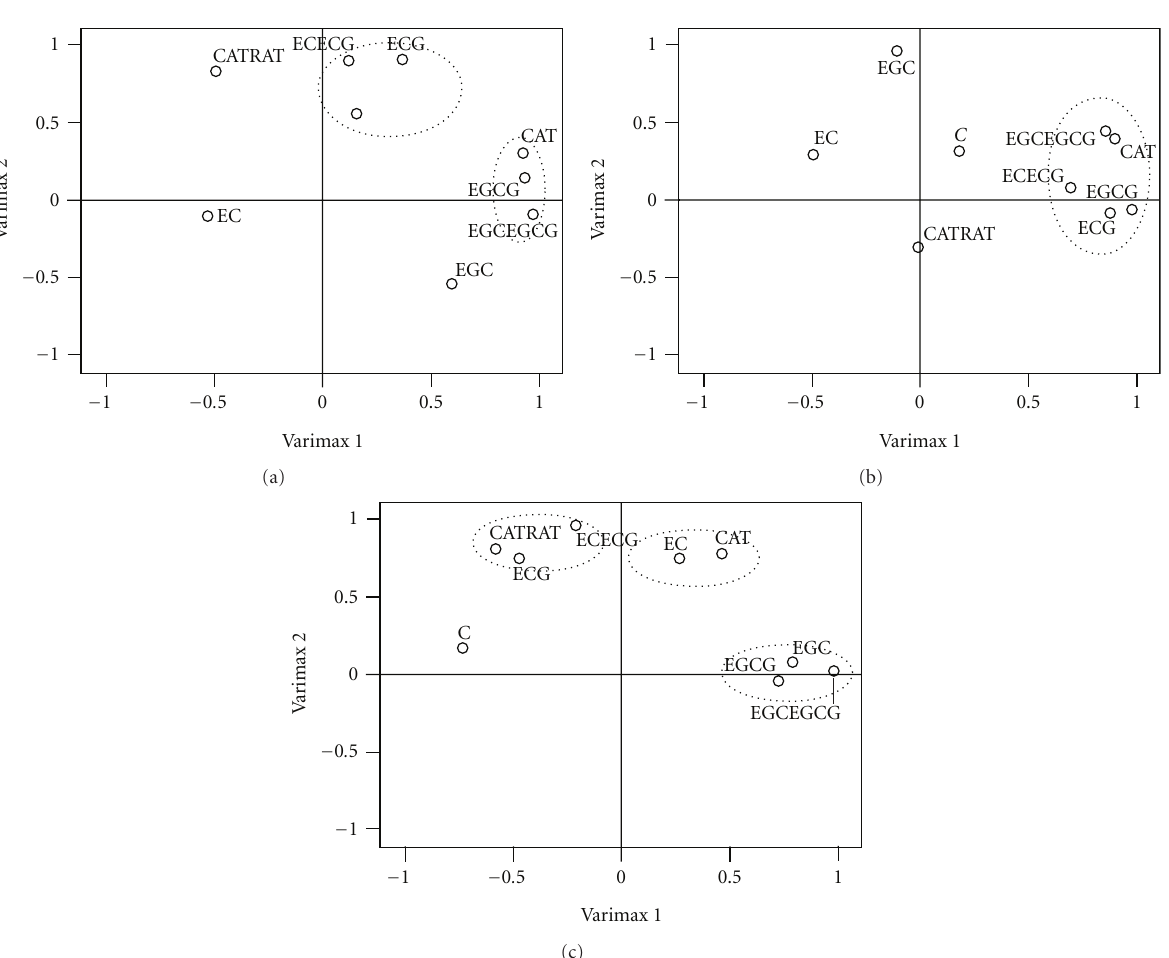
technique to determine genetic diversity in tea